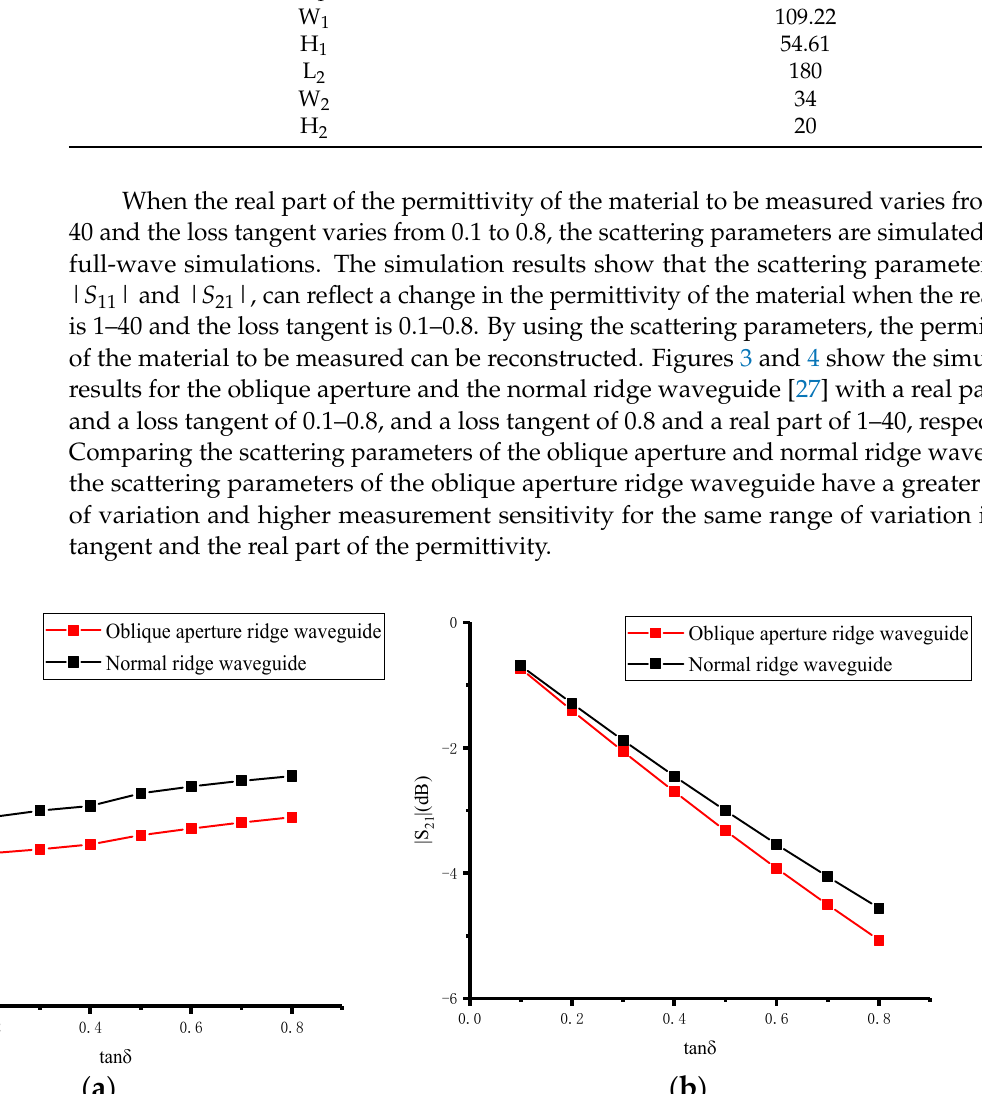
Figure 2. Schematic of the oblique aperture ridge waveguide. Table 1. Structure dimension table of the oblique aperture ridge waveguide.